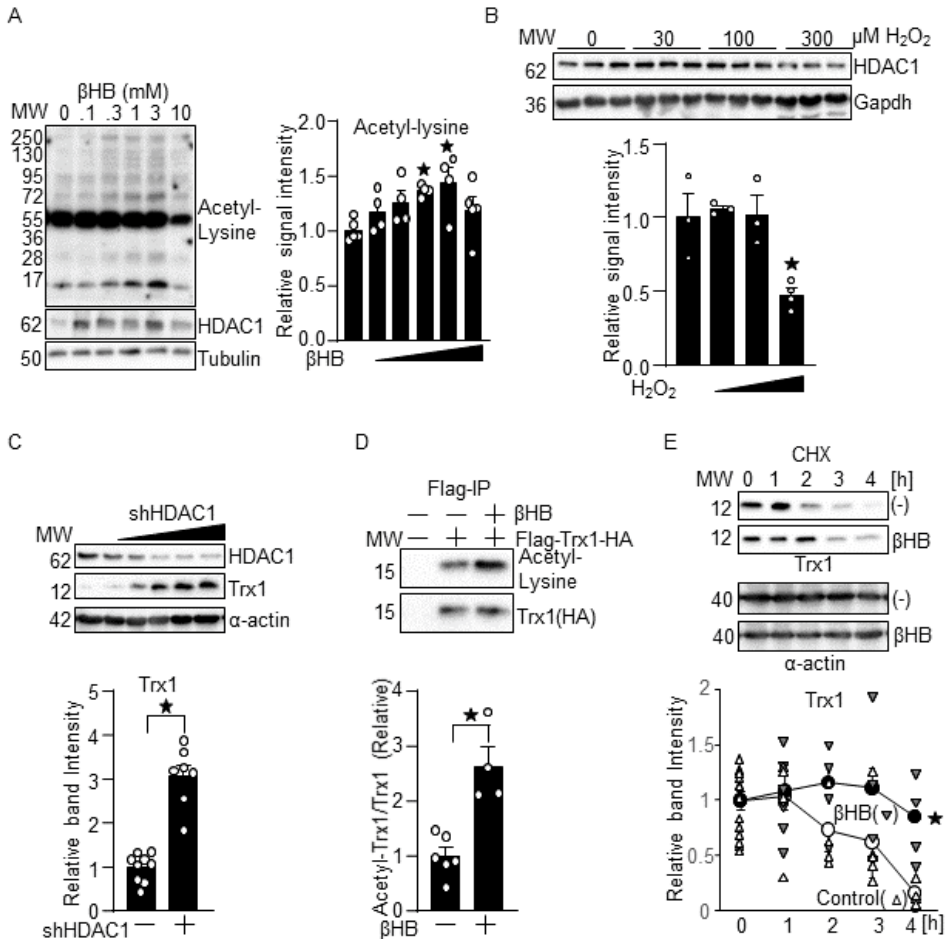
Figure 5. β HB may upregulate Trx1 through HDAC inhibition. ( A ) Dosage effects of β HB on protein acetylation and HDAC1 expression. Cardiomyocytes were treated with the indicated concentrations of β HB for 16 h. n = 4–5. ( B ) Dosage effects of H 2 O 2 upon HDAC1 expression. Cardiomyocytes were treated with the indicated concentrations of H 2 O 2 for 16 h. n = 3–4. ( C ) Knockdown of HDAC1 upregulates Trx1. (Left) Cardiomyocytes were transduced with 0, 0.3, 1, 3, 10, or 30 MOI of shHDAC1 for 3 days. (Right) Trx1 induction by shHDAC1 (3 MOI). n = 7–9. ( D ) β HB induces Trx1 acetylation. Flag- and HA-tagged Trx1 was expressed with adenovirus vector and immunoprecipitated with anti-Flag antibody. n = 4–6. ( E ) β HB inhibits Trx1 degradation. Cardiomyocytes were treated with 100 µ M cycloheximide (CHX) for 1 h followed by 1 mM β HB for 1 to 4 h. n = 4–5. ( A – E ) Western blot analyses were performed with indicated antibodies. * p < 0.05 ( A – E